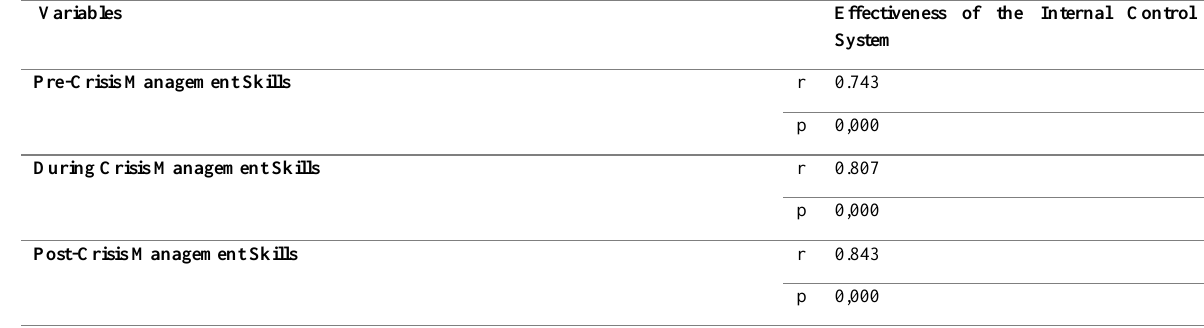
Table 4: Correlation Analysis between Internal Control’s effectiveness and Crisis Management Skills